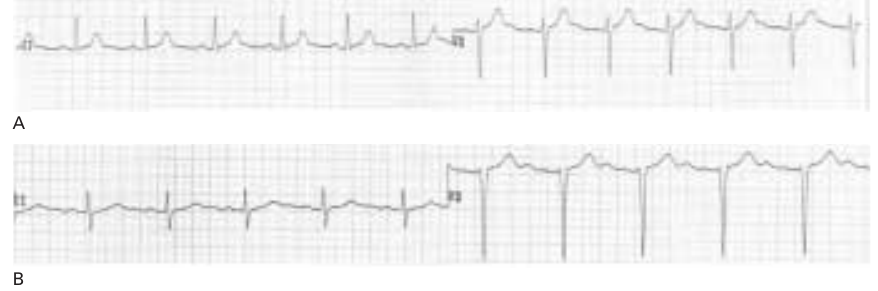
Rhythm strip show- ing sustained TdP-VT (25 mm/sec) after in- crease of methadone to 200 mg/day and addition of